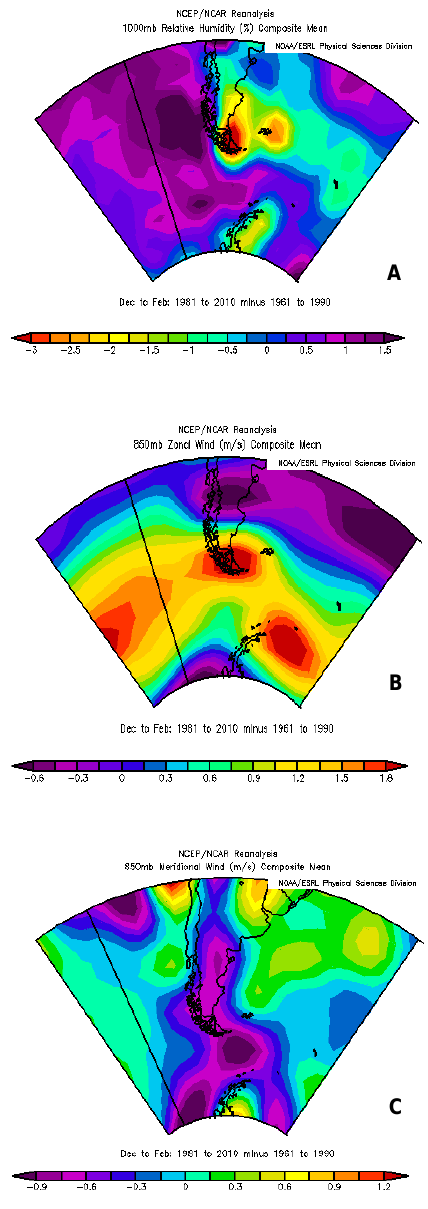
Fig. 7. The 1981–2010 anomaly relative to the 1961–1990 average for (A) 1000mb relative humidity (%), (B) the 850mb zonal wind component (ms − 1 ) , and (C) the 850mb meridional wind compo- nent (ms − 1 ) . Positive values are from the west for the zonal ( u ) component and from the south for the meridional ( v ) component. Basic images are provided by the NOAA/ESRL Physical Sciences Division, Boulder Colorado from